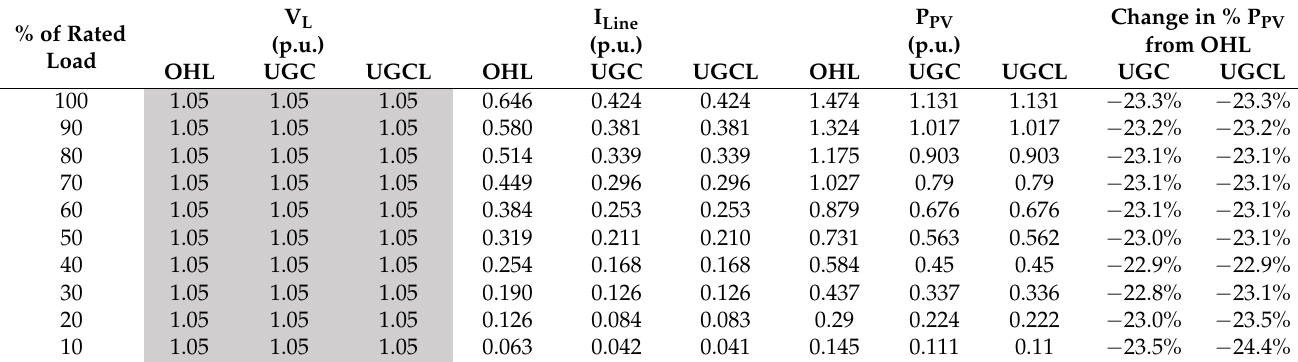
Table 5. Changing the load percentage for the different feeders (Substation voltage V S = 1.05